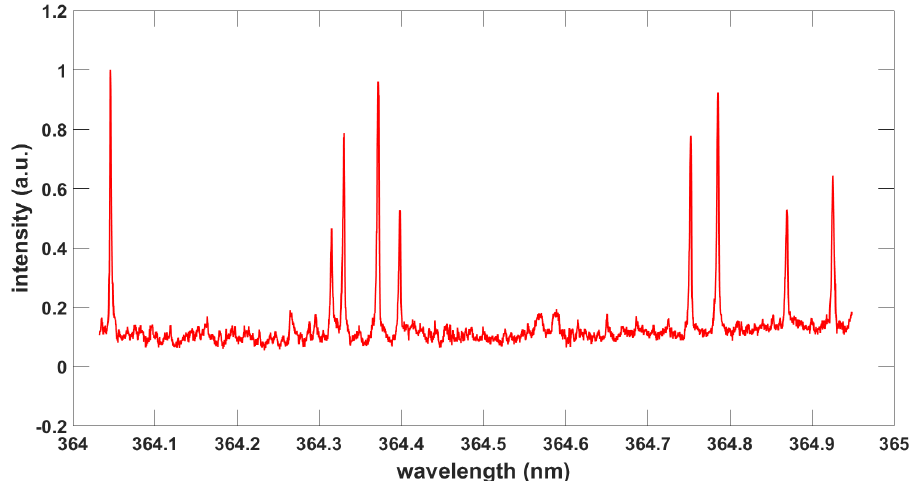
Figure 5. Recorded CH B − X spectrum using